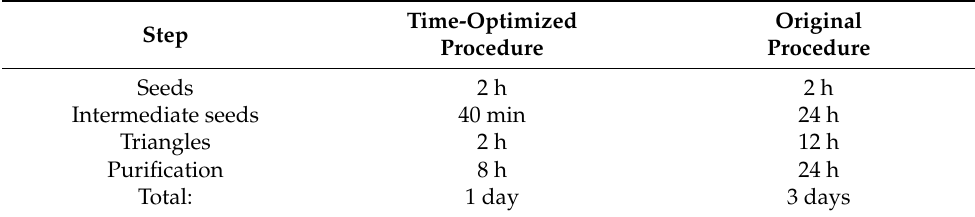
Table 1. Optimization of time consumption for the nanotriangle synthesis.